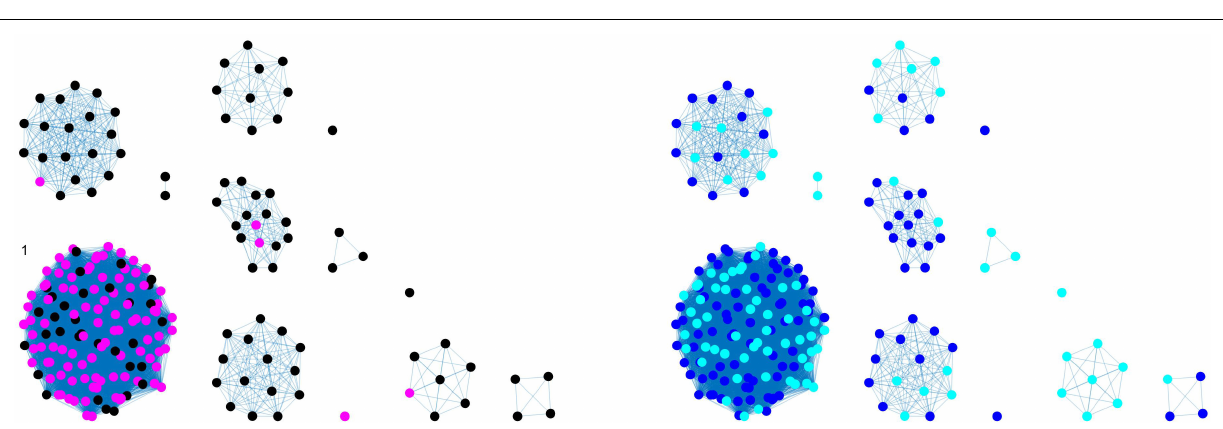
FIGURE 2 | Clustering results (force-directed graph drawing algorithm) obtained by SNP distance matrix, where different node colors represent different serotypes (left) and different sampling years (right) . Legend for left-hand figure: pink, monophasic; black, Typhimurium. Legend for right-hand figure: 2013, blue; 2014,